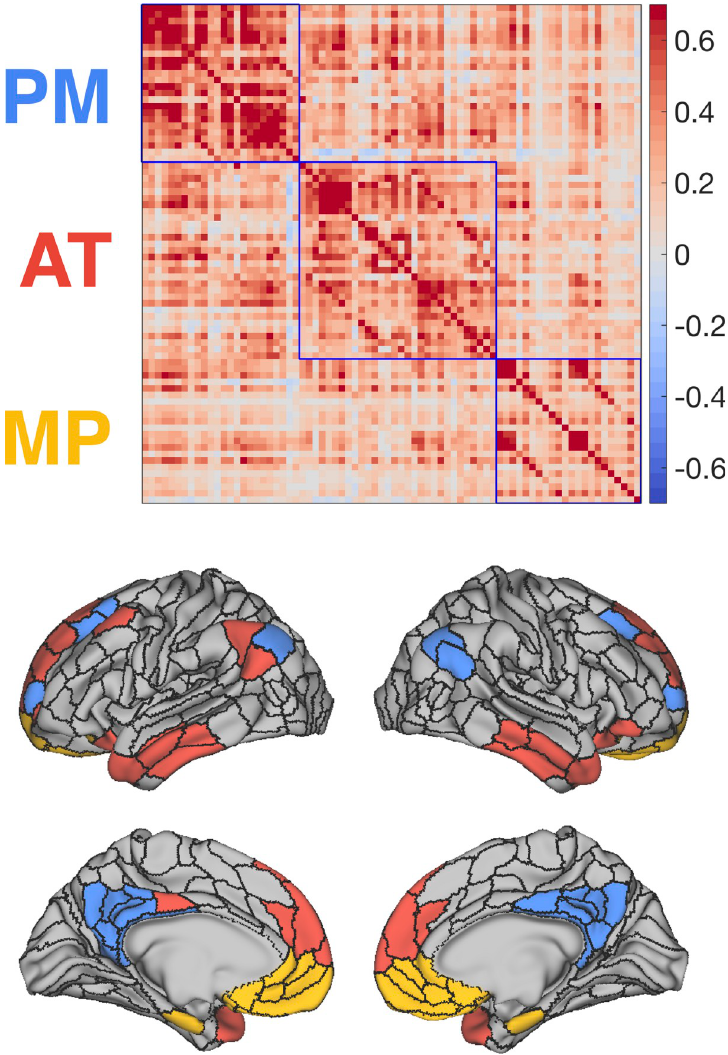
Fig 3. The DMN can be partitioned into 3 interconnected subnetworks. (A) FC matrix organized by subnetwork. Color bar represents Fisher Z-transformed correlation values. (B) Inflated cortical surface, colored according to community membership of subnetworks. AT, anterior temporal; DMN, default mode network; FC, functional connectivity; MP, medial prefrontal; PM, posterior medial. Data can be found at https://github.com/ajbarn/hippo_